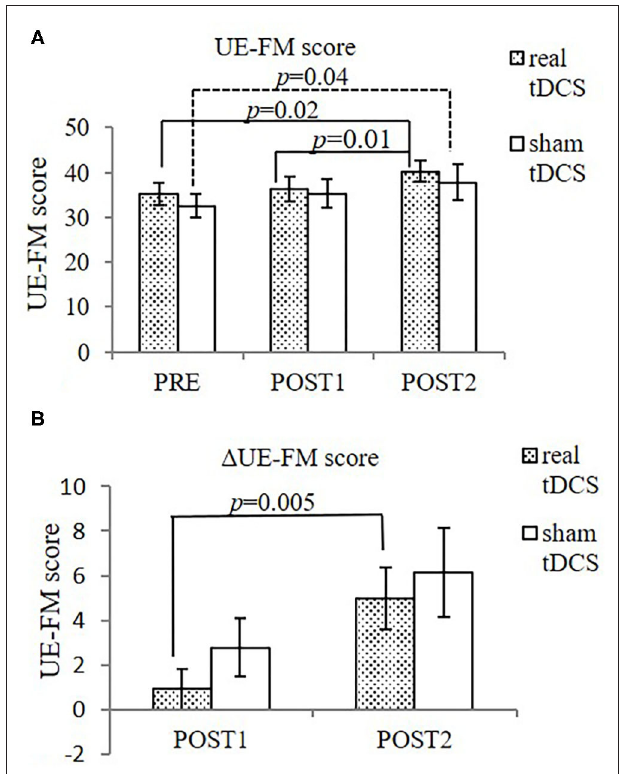
FIGURE 2 | UE-FM score (A) and 1 UE-FM (B) in both groups. (A) Both groups improved significantly in UE-FM at POST2 after intervention ( n = 10 for real-tDCS group, n = 9 for sham-tDCS group). Between group difference was not statistically significant. (B) 1 UE-FM (changes in UE-FM score compared to PRE) was significantly higher at POST2, compared to POST1 in the real-tDCS group, not in the sham group. Data shows mean ±